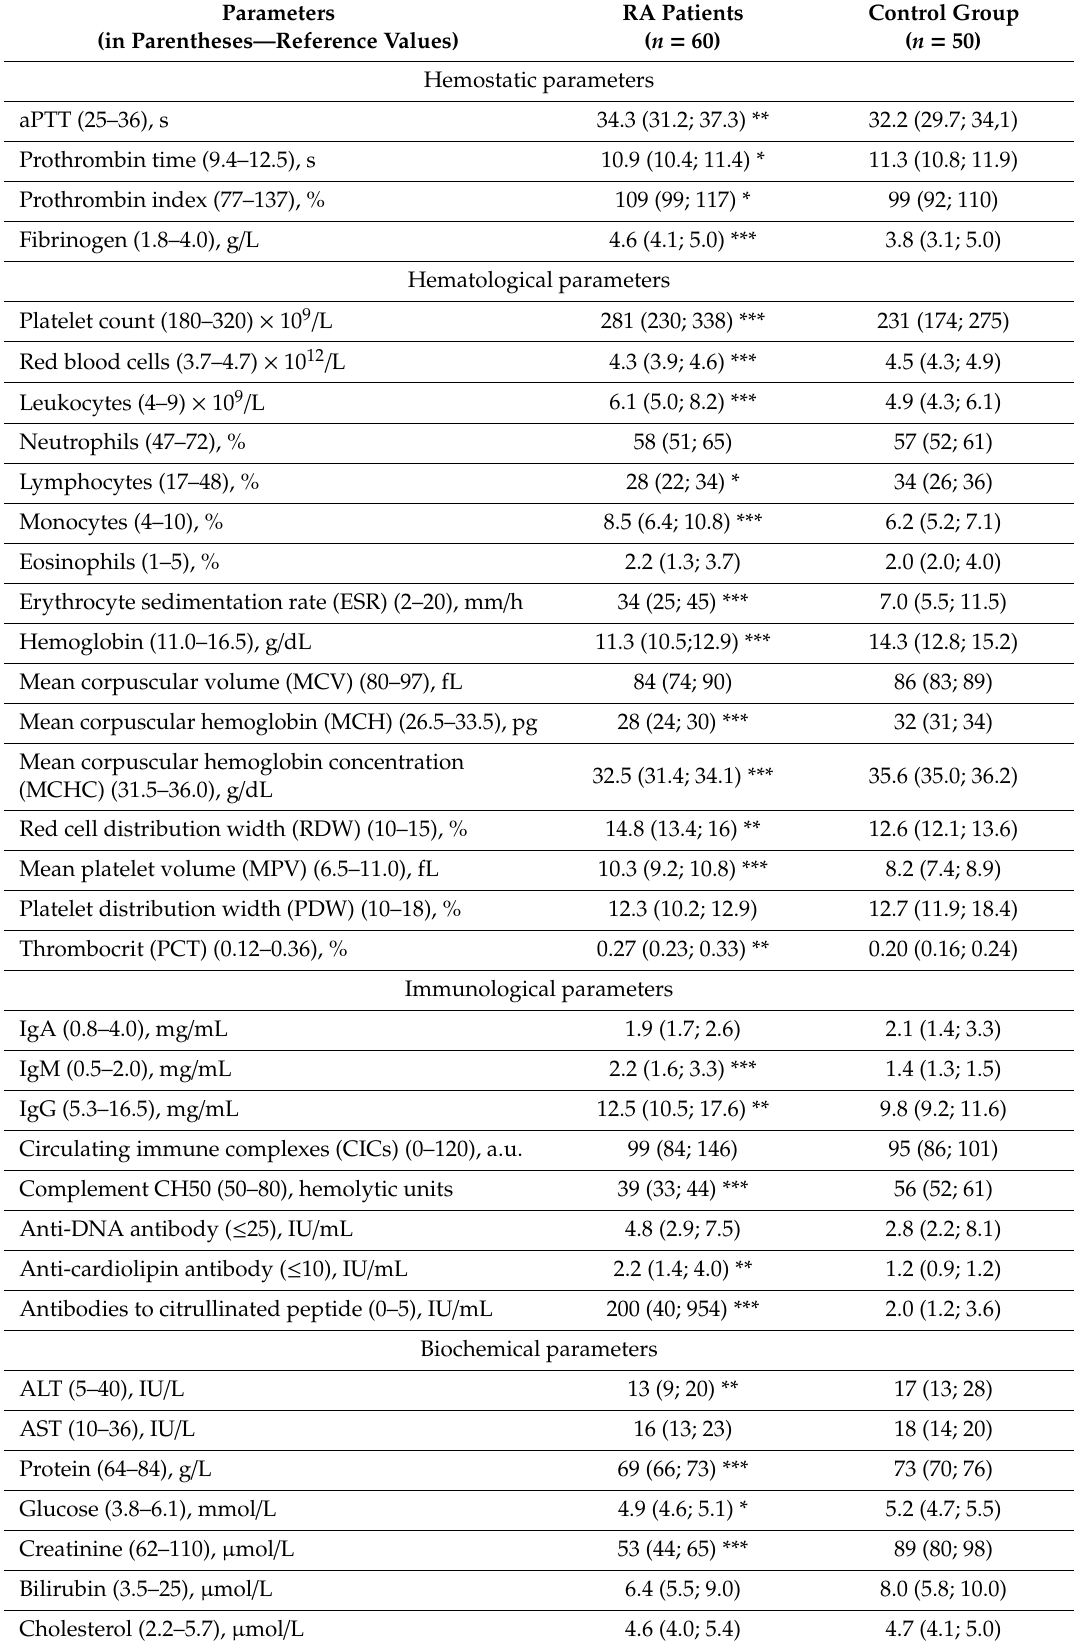
Table 3. Laboratory parameters in the RA patients compared with the control